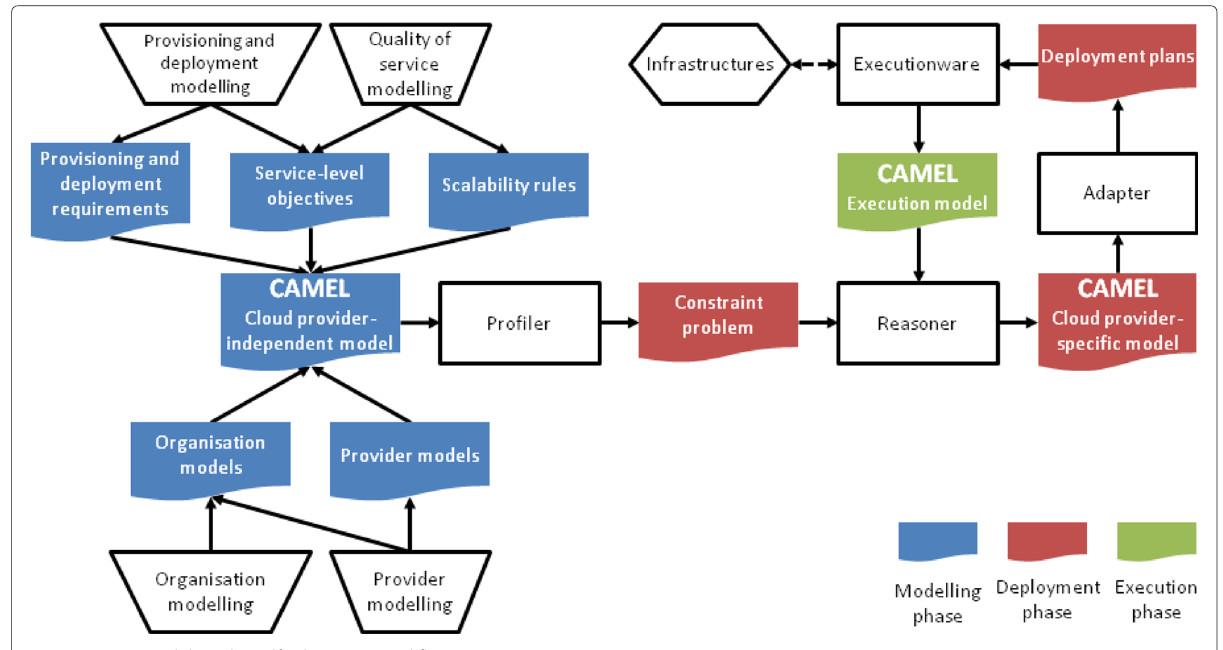
Fig. 3 CAMEL models in the self-adaptation